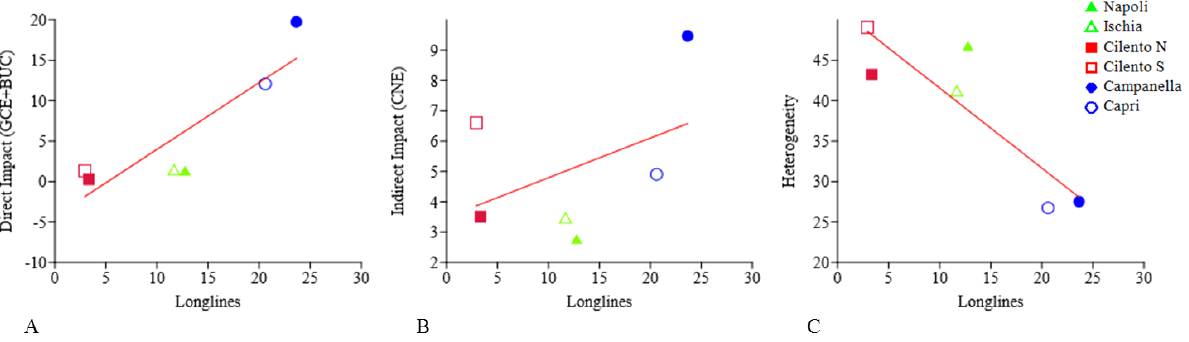
Figure 11. Linear regressions between longlines and direct impact (( A ), p = 0.0086, r 2 = 0.77), indirect impact (( B ), no correlation), and heterogeneity (( C ), p = 0.035, r 2 = 0.77). Table 3. Mean (± SD) of linear regression independent (longlines) and dependent variables (direct impact, indirect impact, and heterogeneity).